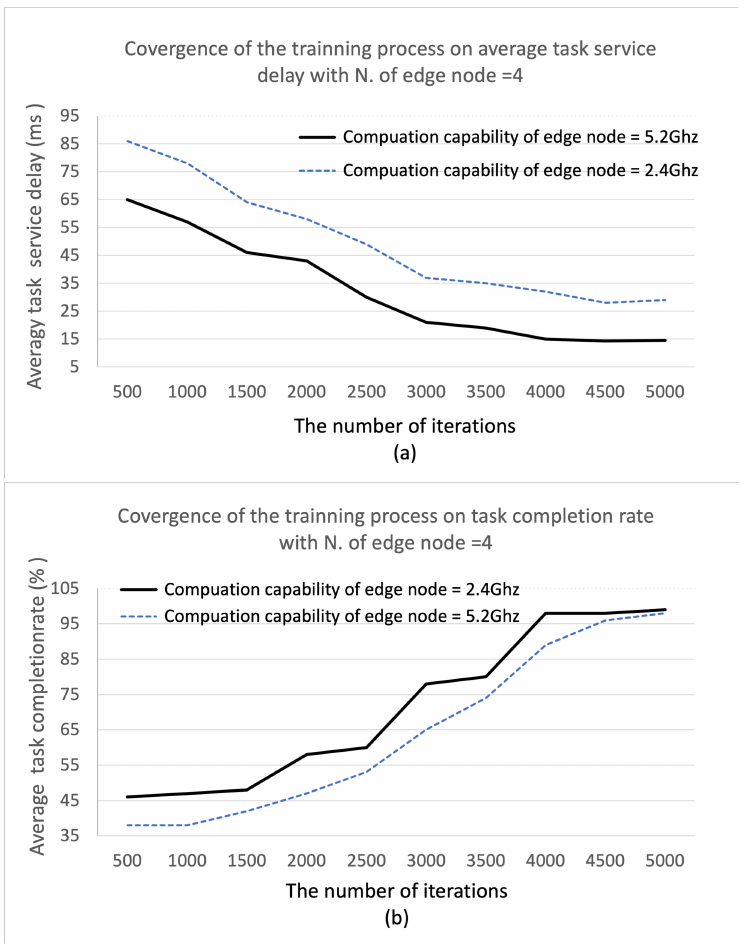
Figure 5. The convergence performance of the proposed DDM model on: ( a ) average task service delay; ( b ) task completion rate with the number of edge node = 4.